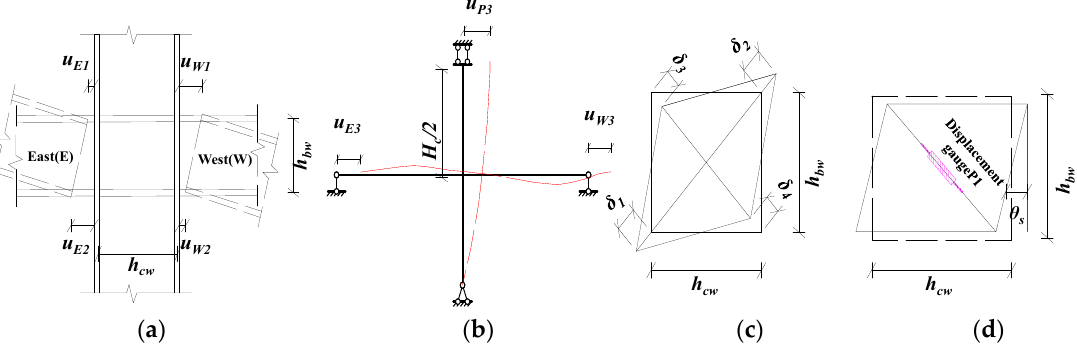
Figure 7. Method for measuring rotation angle of beam-to-column joints: ( a ) Method 1 calculating the angle of the beam end-plate; ( b ) Method 2 calculating the angle of beam end-plate; ( c ) Method 1 calculating the shear angle; ( d ) Method 2 calculating the shear angle.